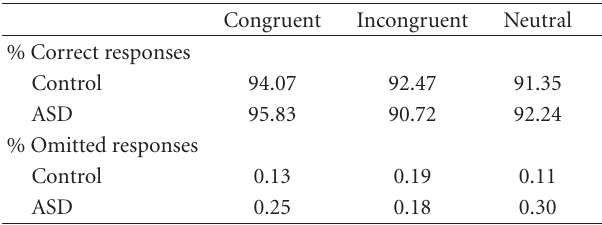
Table 2: Percentage of correct and omitted responses for each trial type in ASD and control